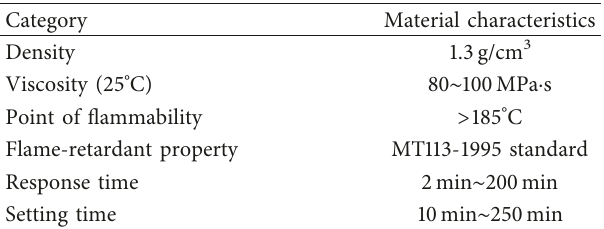
Table 2: Main characteristics of the chemical grouting